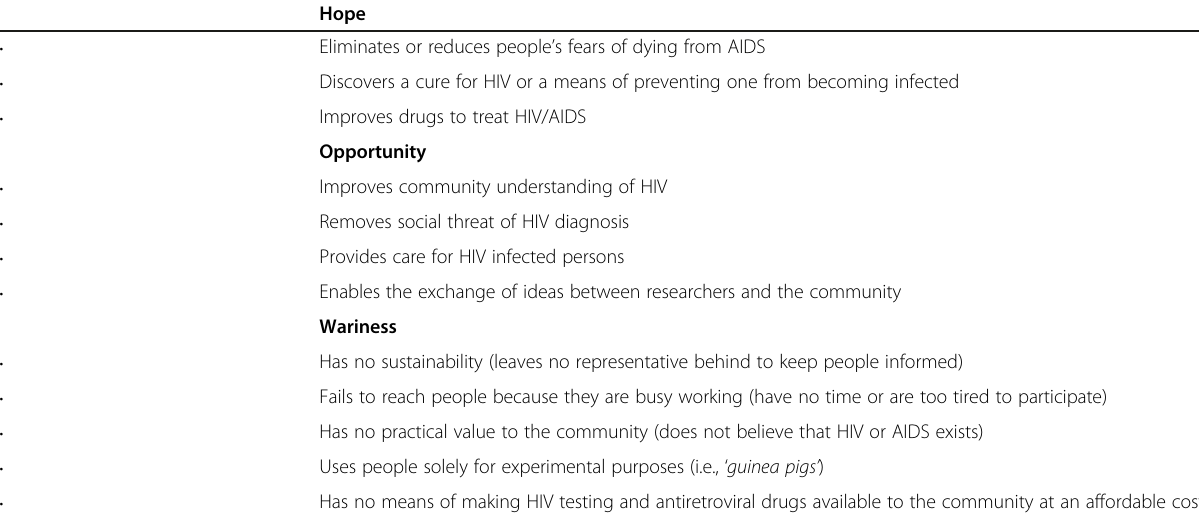
Table 2 FGD and KII participant ’ s perceptions about community-held attitudes toward HIV research express1ed by plantation FGD and KII participants, August-October 2006